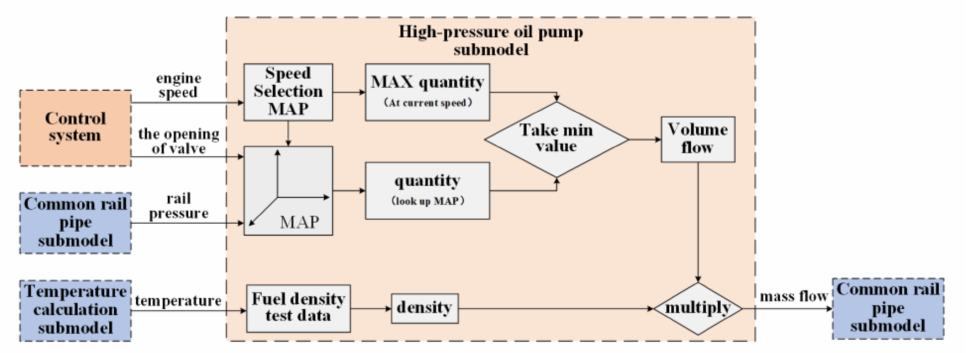
Figure 11. Development process of the pump submodel.